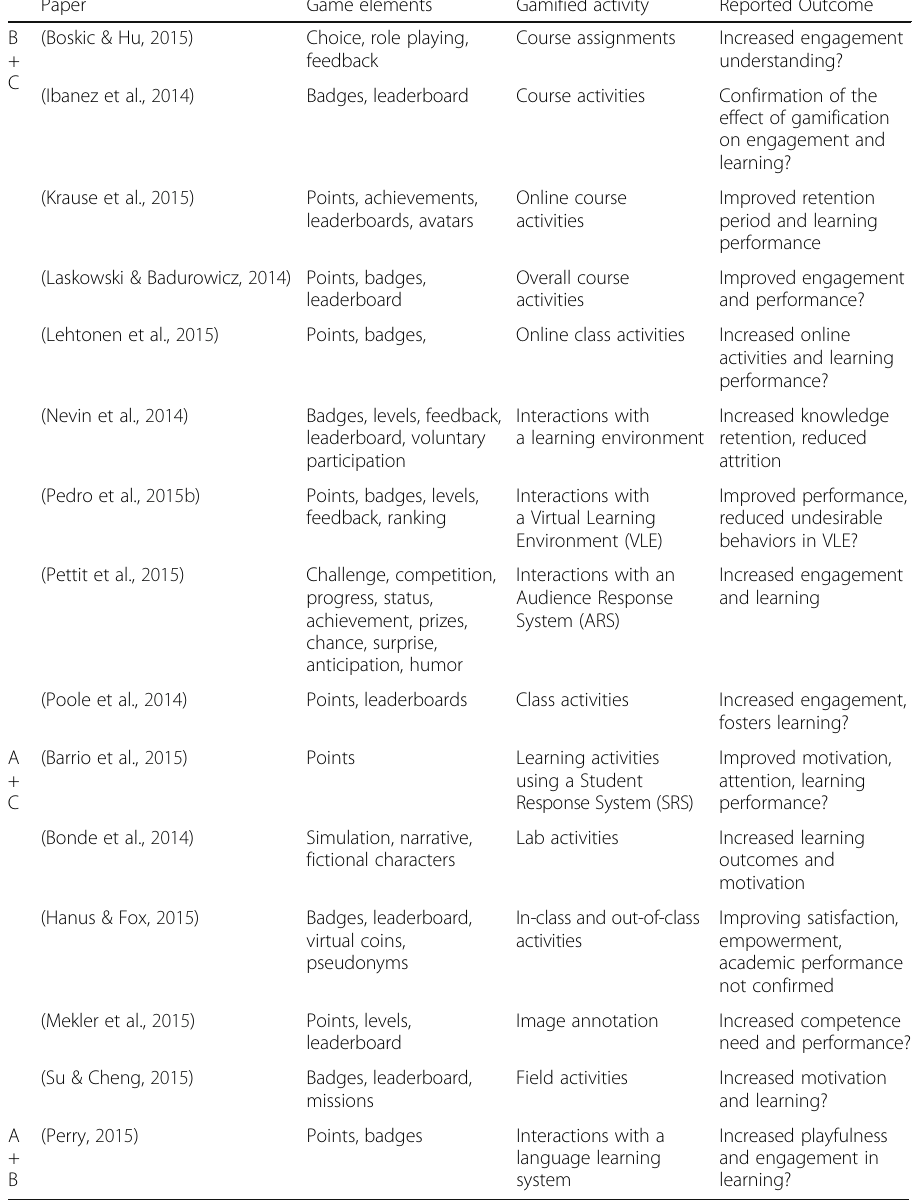
Table 7 Categorization of studies falling in two categories: Behavioral and Cognitive (B + C), Affective and Cognitive (A + C), Affective and Behavioral (A +